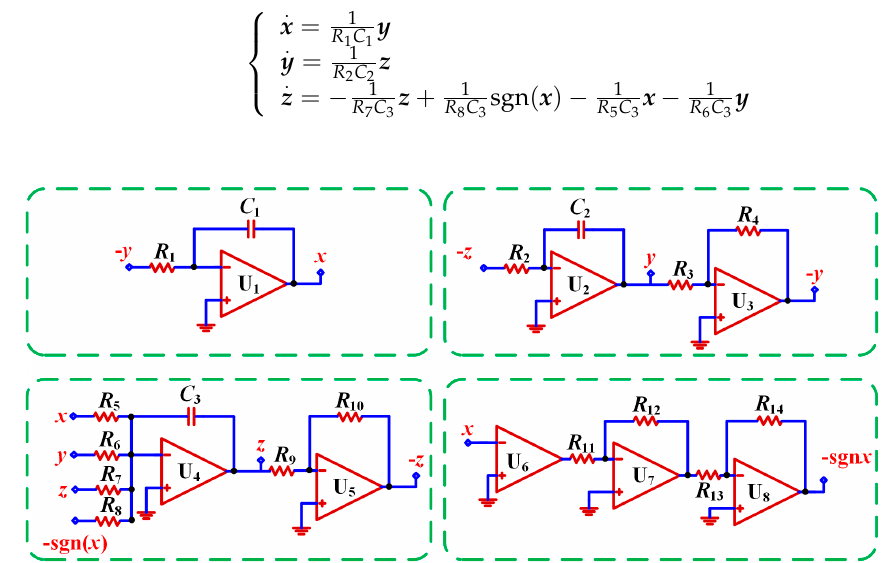
Figure 2. Phase trajectory diagram of the chaotic system. ( a ) the phase trajectory of x – y , ( b ) the phase trajectory of z – x , ( c ) the phase trajectory of z – y , and ( d ) the phase trajectory of x – y – z . We designed the chaotic circuit corresponding to the chaotic system to implement the encryption on the hardware. The proposed scheme utilizes the chaotic signal generated by the chaotic circuit to drive the PM to encrypt rather than the optical carrier, and the transmission capacity is no longer limited by the bandwidth of the chaotic signal. The chaotic circuit has the characteristics of small size, low cost and high sensitivity. Its size is only 10 cm × 5 cm. The circuit is composed of three channels, which are integrated according to the state variables x , y , and z , respectively. The circuit schematic of system (1) was designed as shown in Figure 3. The construction of the corresponding chaotic circuit can be represented as: